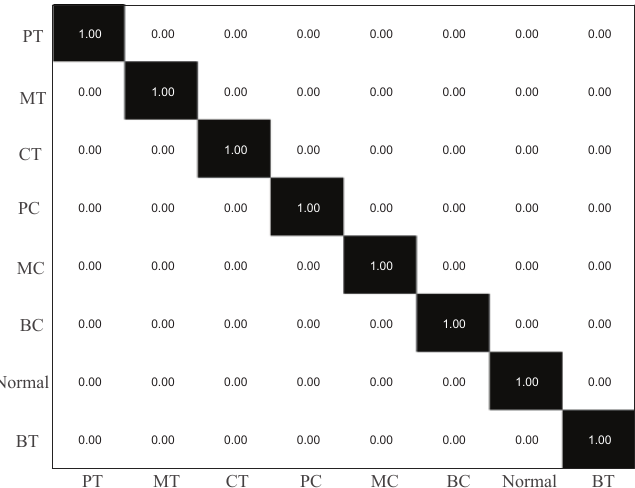
Figure 8. The classification results of the IRT–CNN method.